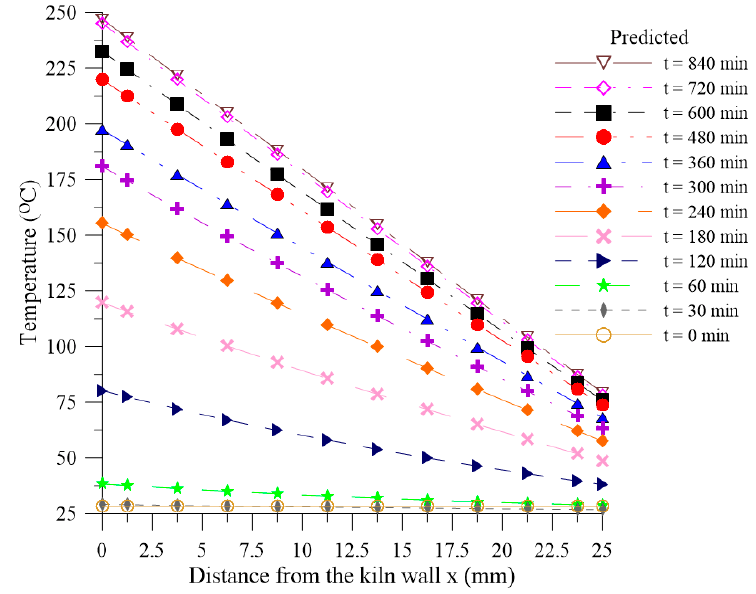
Figure 21. Temperature inside the thermal insulation for several instants of time.